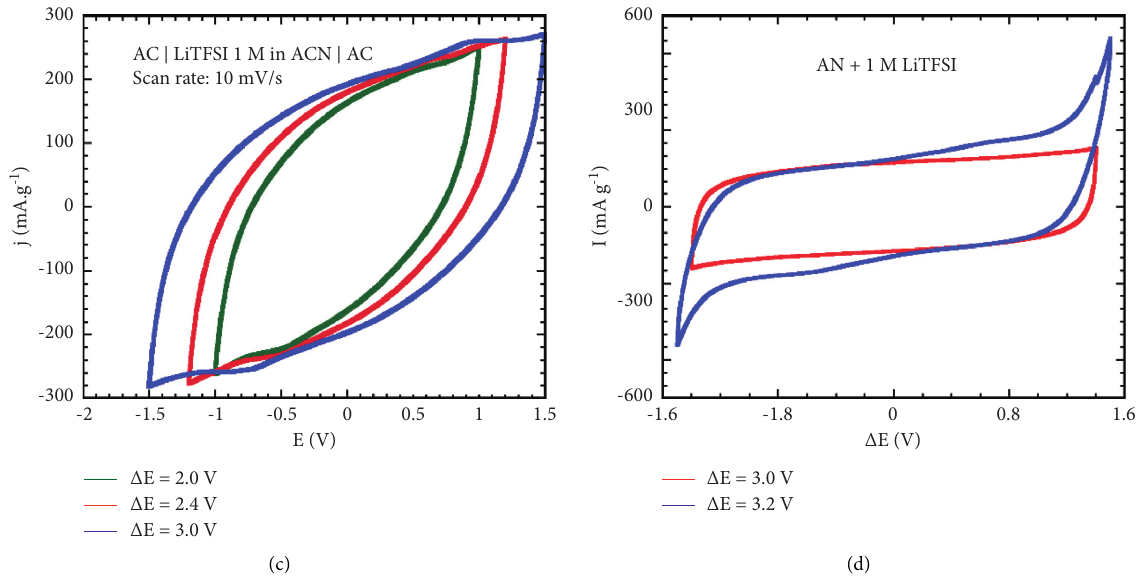
Figure 7: CV curves of supercapacitors using (a) DES 1:4 + x % wt. AN, (b) DES 1:4 + x %wt. AN in the potential window of 3.2V, (c) AN+1M TBABF4, and (d) AN+1M LiTFSI at different potential windows ( v � 10 mV · s − 1 Table 5: Q v � 10mV · s − 1 . charge / Q discharge and capacitance with different potential windows at Q charge / Q discharge Capacitance (F · g − 1 ) No. cycle (%) Average capacitance loss (%)